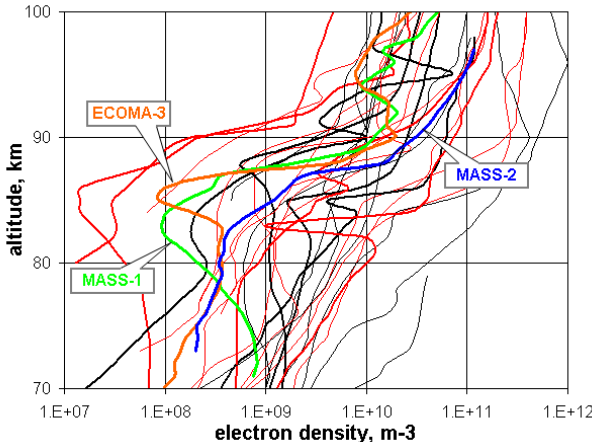
Fig. 3. High latitude electron densities measured in the PMSE sea- son (zenith angles 48 ◦ to 96 ◦ , 31 May to 18 August). Profiles that were intentionally obtained during NLC or PMSE are marked in red, pronounced bite-outs by bolder